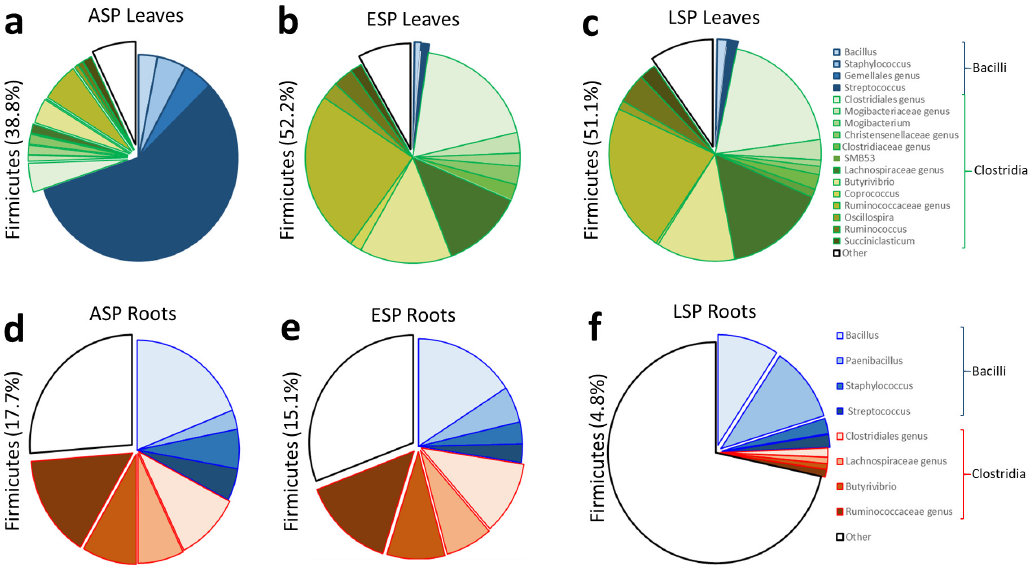
Figure 7. Pie graphs describing the relative abundance of genera in the Firmicutes phylum . Between brackets is indicated the total share of the phylum , while each genus is represented by the size of the corresponding slice. ( a ) ASP leaves; ( b ) ESP leaves; ( c ) LSP leaves; ( d ) ASP roots; ( e ) ESP roots; ( f ) LSP